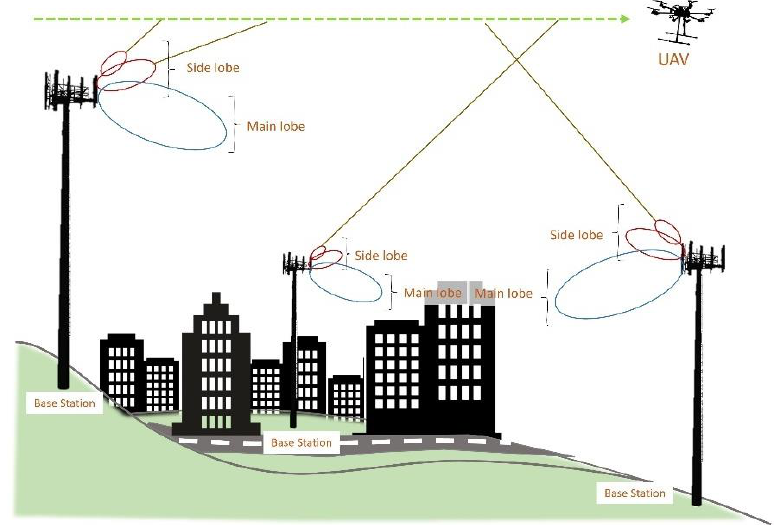
Figure 1. Illustration of cellular-connected UAV.